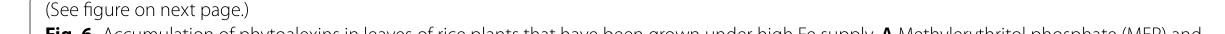
Fig. 6 Accumulation of phytoalexins in leaves of rice plants that have been grown under high Fe supply. A Methylerythritol phosphate (MEP) and diterpenoid phytoalexin biosynthesis pathways in rice. Genes whose expression is up‑regulated by M. oryzae infection in control and high‑Fe plants are indicated in purple color. The full name and details on the expression of these genes can be found in Additional file 6: Table S5. B Heat map showing expression levels (row scaled FPKM, fragments per kilobase per million reads) in leaves of Control and High‑Fe plants, mock‑inoculated and M. oryzae ‑inoculated plants (48hpi). Gene expression is represented from pale yellow (less expressed) to brown (more expressed). C Accumulation of phytoalexins, diterpenoid phytoalexins and sakuranetin, in leaves of Control and High‑Fe plants at 48 hpi and 72 hpi with M. oryzae spores: momilactones (A and B), phytocassanes (B, C, and E), and the flavonoid phytoalexin sakuranetin ( , mock‑inoculated; , M. oryzae ‑inoculated). − + Data are mean SEM of three biological replicates each with five plants. Asterisks indicate statistically significant differences calculated by two‑way ± ANOVA (*** P 0.001). G3P, glyceraldehyde‑3‑phosphate; DXP, 1‑deoxy‑D‑xylulose 5‑phosphate; MEP, 2‑ C‑methyl‑D‑erythritol 4‑phosphate; ≤ CDP‑ME, 4‑(cytidine 5 ′ ‑diphospho)‑2‑C‑methyl‑D‑erythritol; CDP‑ME2P, 2‑phospho‑4‑(cytidine 5 ′ ‑ diphospho)‑2‑C‑methyl‑D‑erythritol;